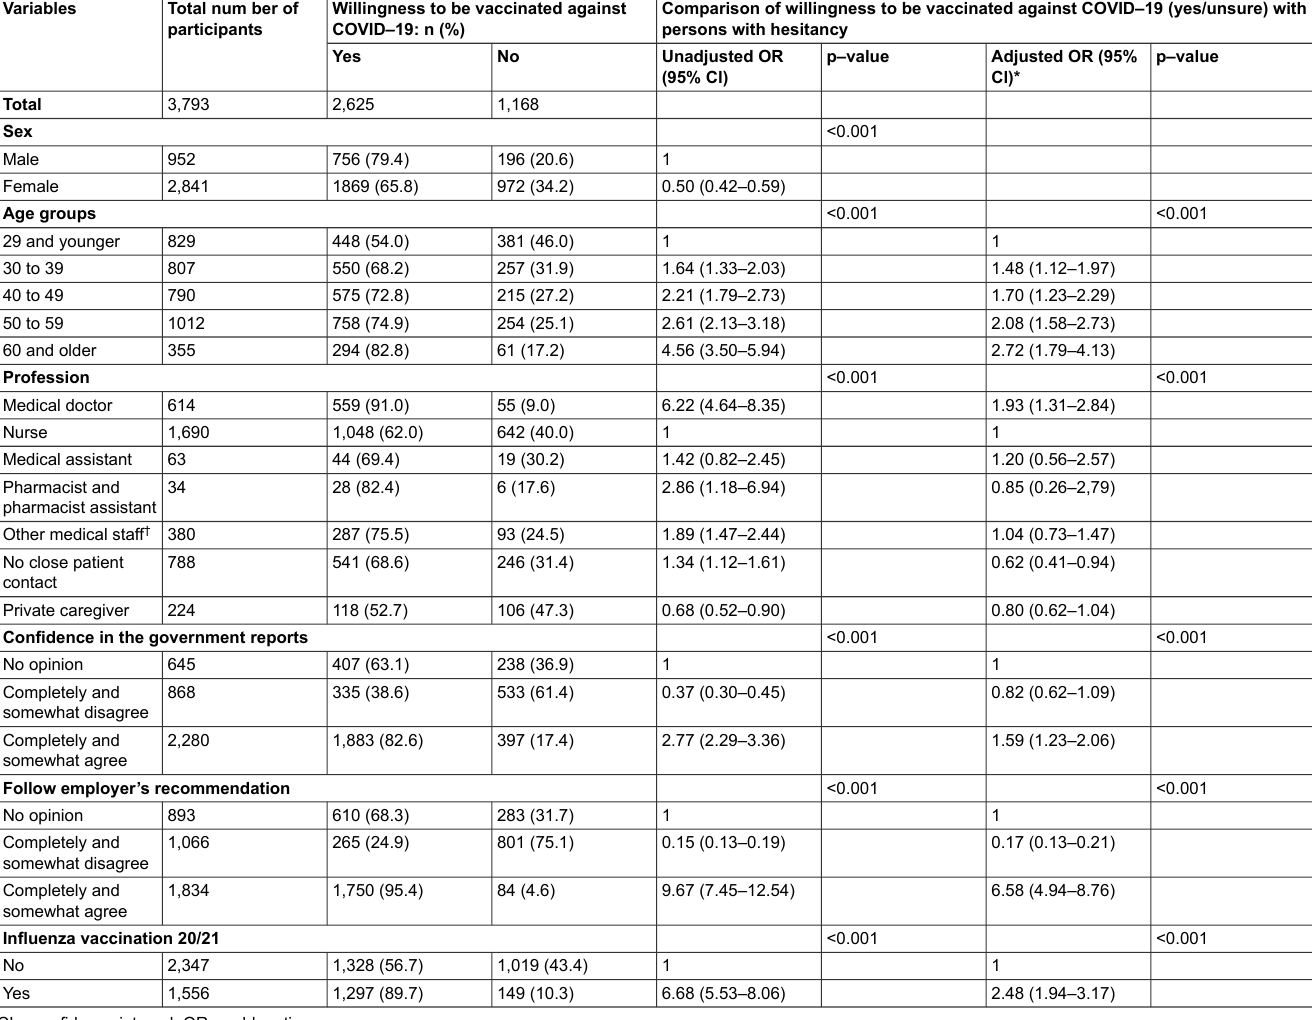
Table S3: Sensitivity analysis: Determinants for the willingness to be vaccinated against COVID-19 (yes/unsure) among healthcare workers compared with healthcare workers with hesi- tancy.